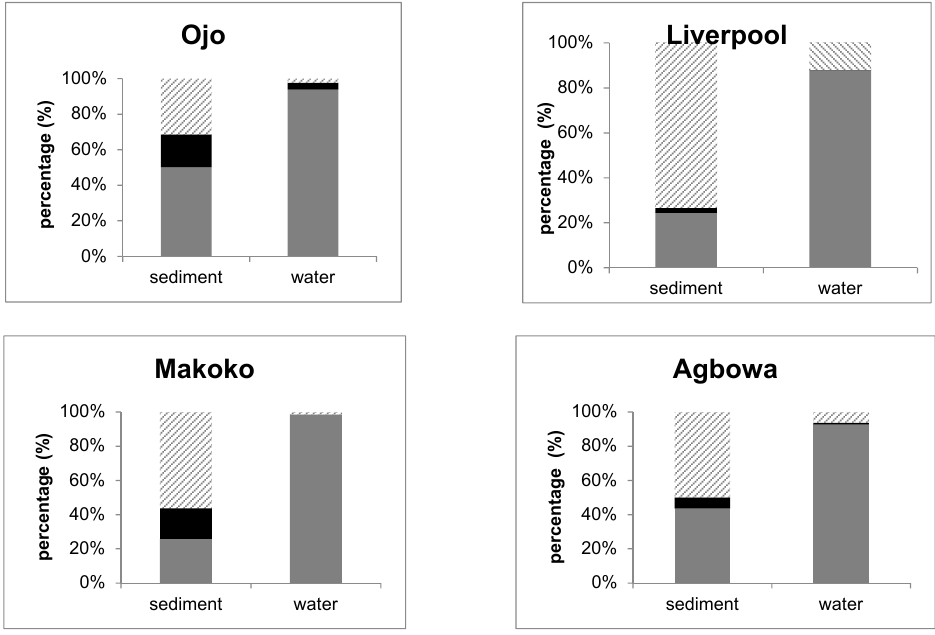
Figure 3. Form of microplastics in water and sediment samples (grey: fibre, black: foil, dashed line: fragment).